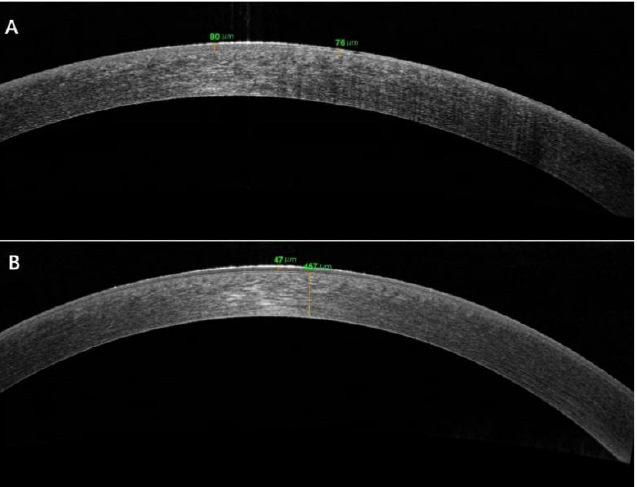
Figure 3. Anterior segment OCT examination revealed epithelial thickness in the onset ( A ) and recovery stages ( B ).